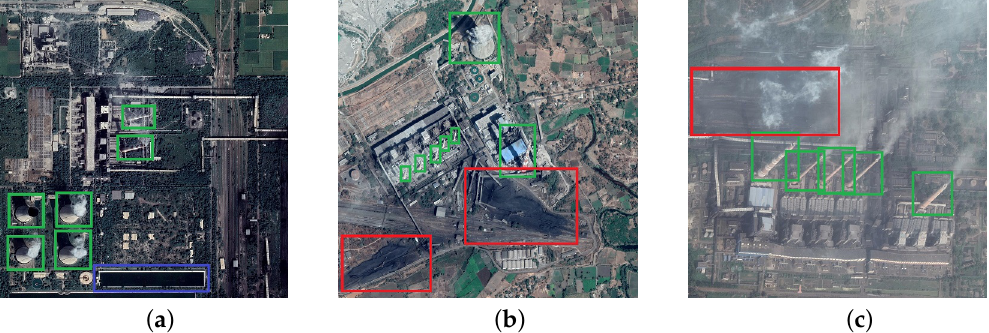
Figure 2. Samples of thermal power plants with diverse separate irregular components including chimneys (green bounding boxes), coal yards (red bounding boxes), pools (blue bounding boxes) and other processing buildings. ( a ) Bathinda thermal power plant; ( b ) Ukai thermal power plant; ( c ) Korba power